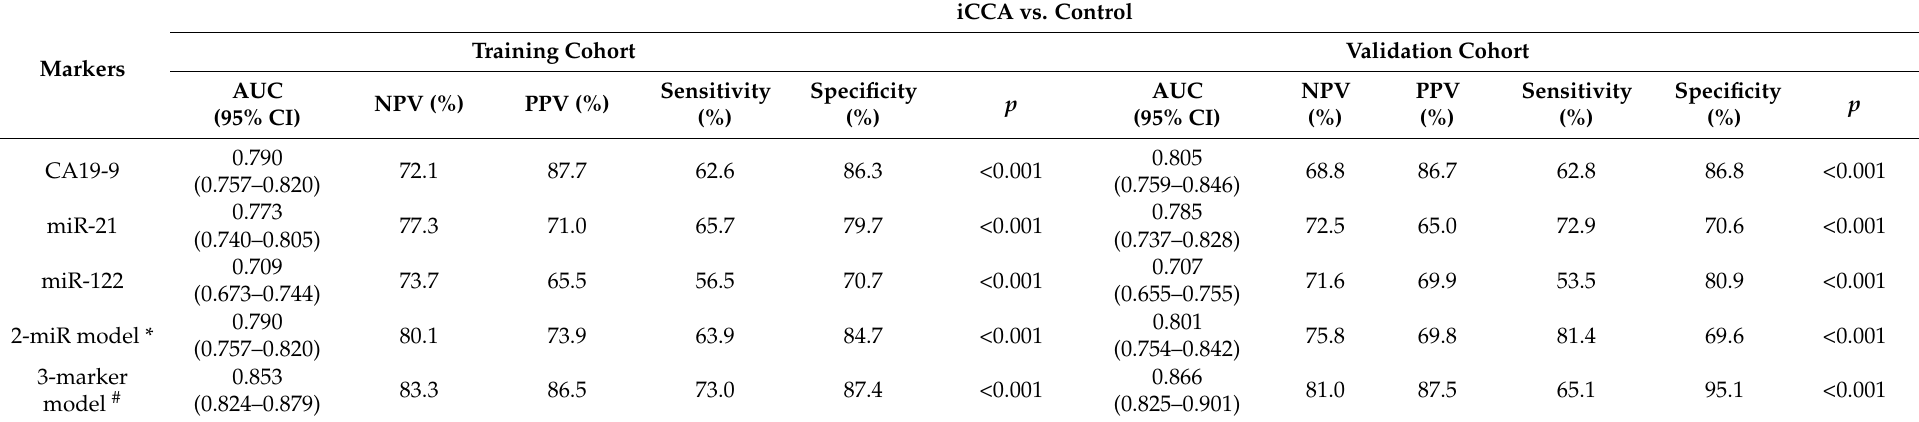
Table 3. Diagnostic performance of circulating markers for iCCA in the training and validation